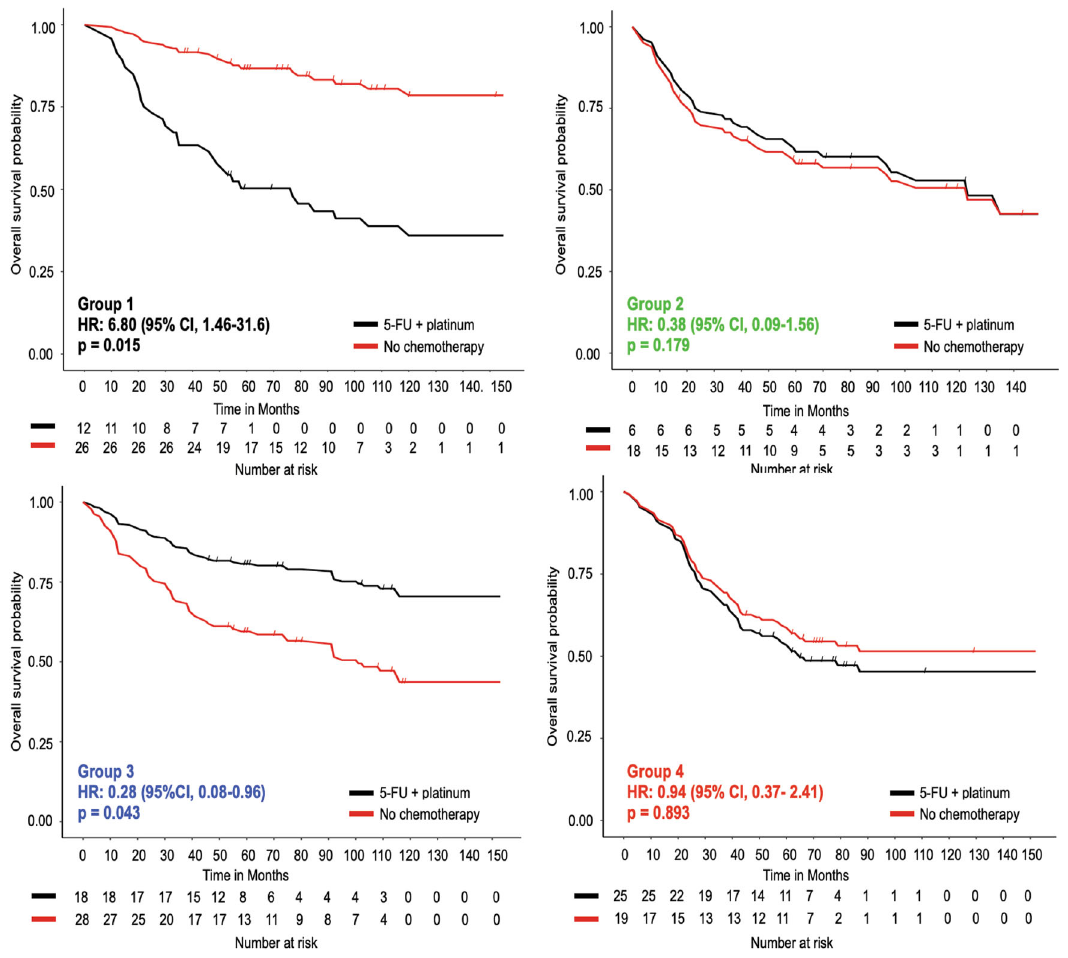
Fig. 3 The molecular subtypes are associated with response to adjuvant 5- fl uorouracil (5-FU) and platinum chemotherapy. Kaplan – Meier curves for overall survival for patients treated at Yonsei University, strati fi ed by molecular subtype. Patients who underwent surgery with no adjuvant chemotherapy are compared to ones who received surgery and adjuvant 5-FU and platinum. The log-rank test was used to test statistical signi fi cance. Source data are provided as a source data fi